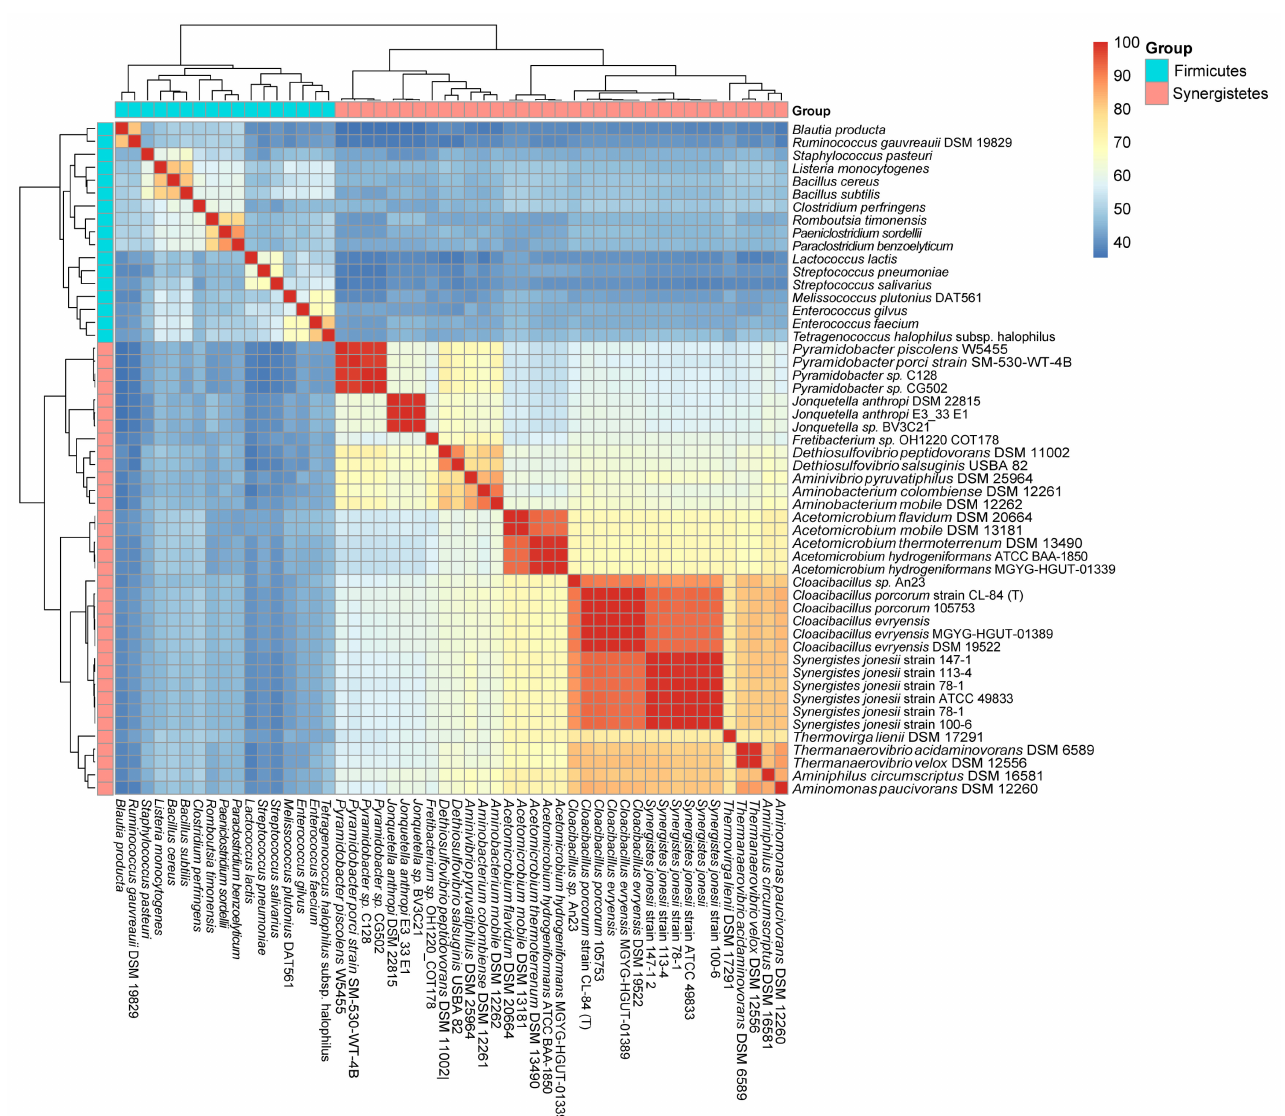
Figure 1. A heat map showing the identity between the CodY/CodY-like proteins from species of Firmicutes and Synergistetes. The score is the % identity of the deduced amino acid sequence of codY and its